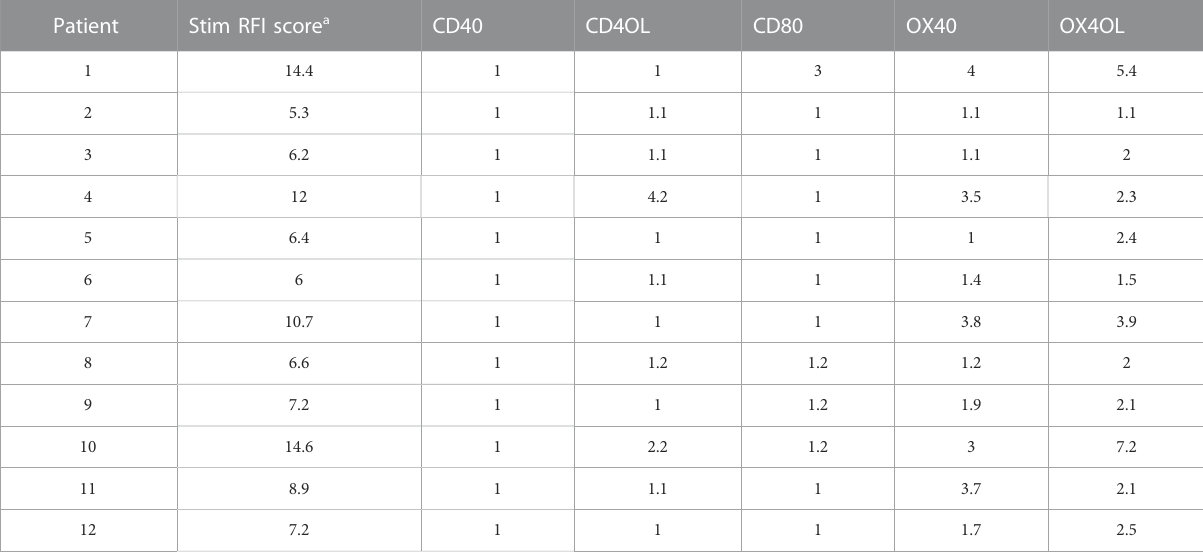
TABLE 2 Immunostimulatory proteins in MTEX. a